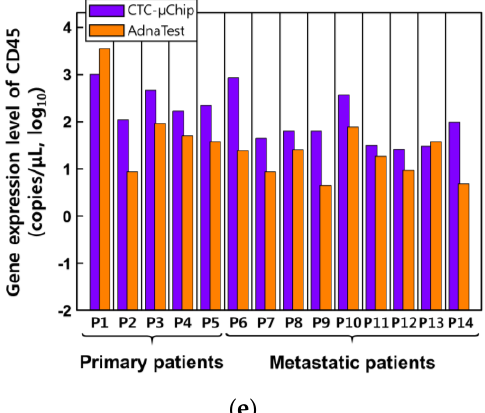
Figure 6. The expression levels of the selected five genes ( a ) AR, ( b ) AR-V7, ( c ) PSMA, ( d ) KRT19, and ( e ) CD45) in CTCs isolated from patients with prostate cancer. Primary cancer patients are marked P1 to P5 ( n = 5), and metastatic cancer patients are marked P6 to P14 ( n = 9).